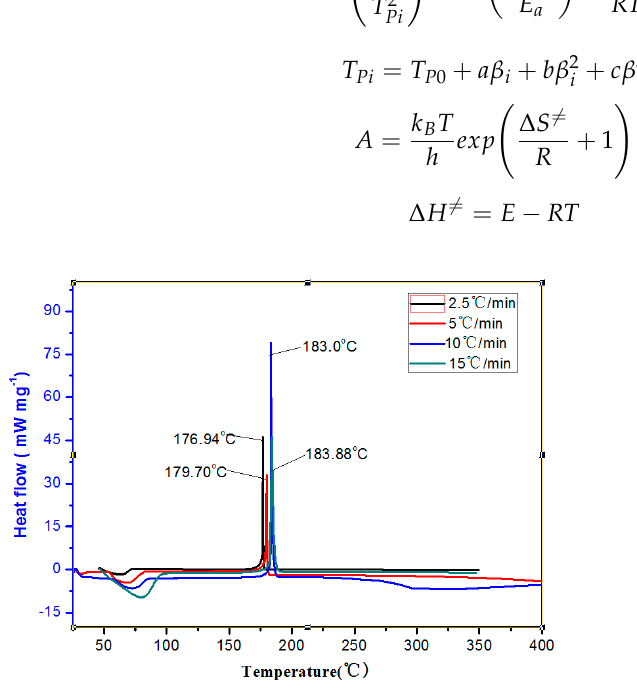
Figure 4. DSC-TG experiments of NPTO ∙ 2H 2 O.